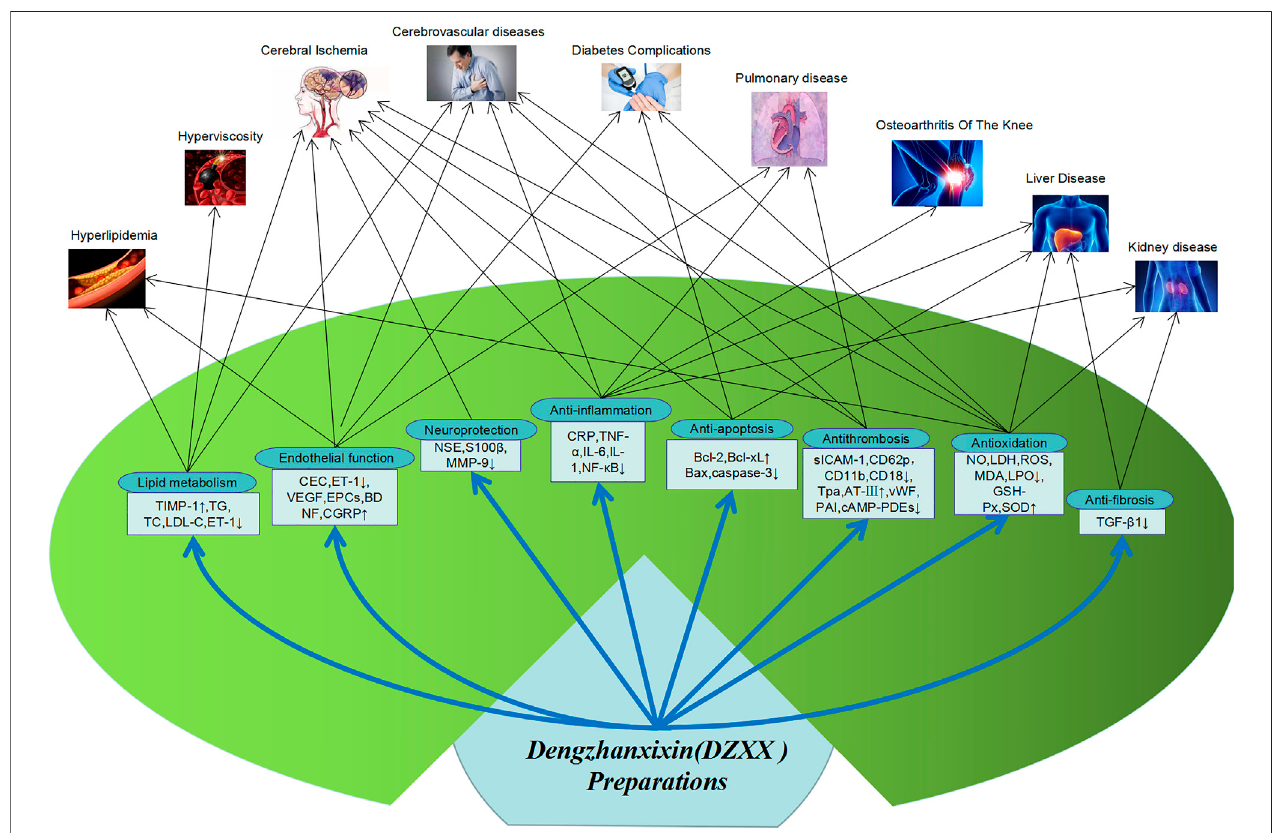
FIGURE 2 | Main pharmacological action and action mechanism of DZXX